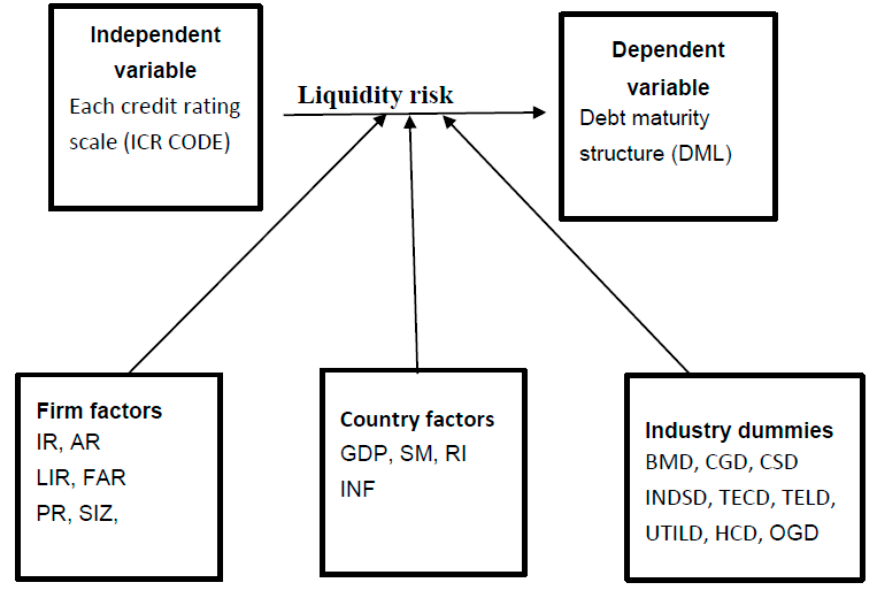
Figure 1. A conceptual